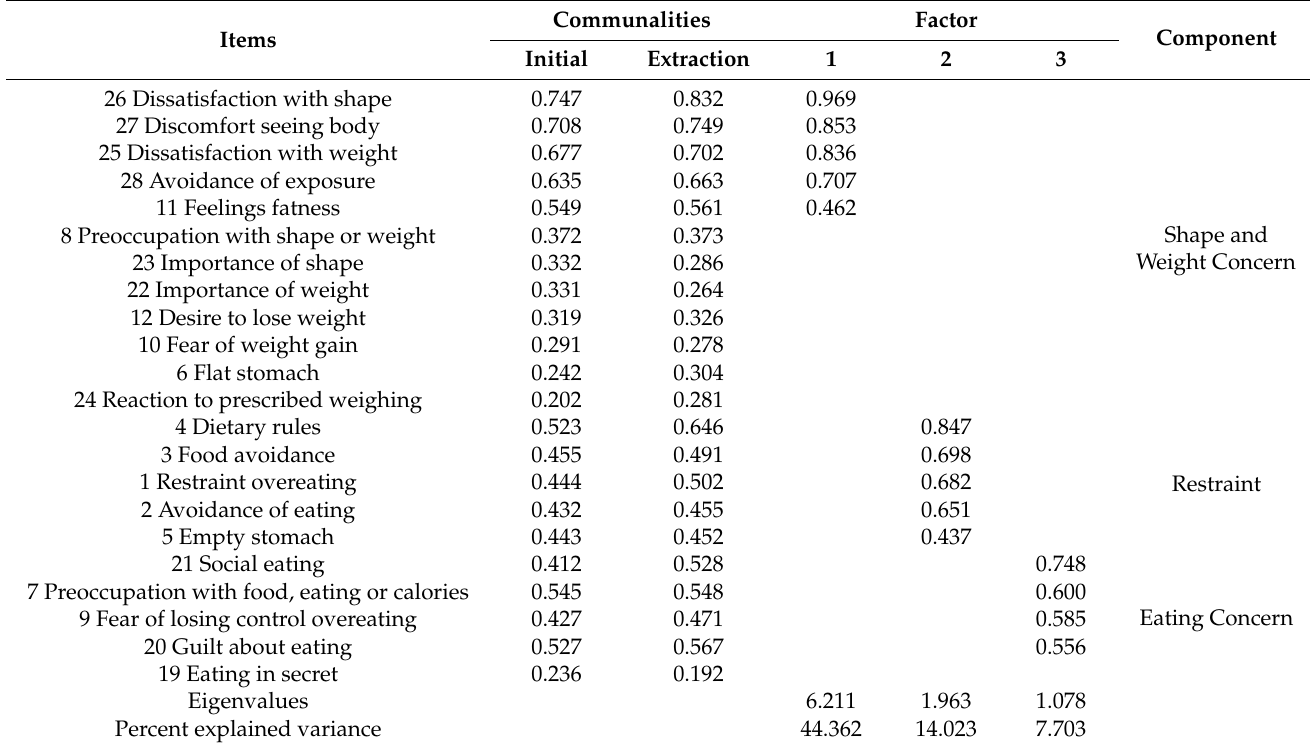
Table 3. Exploratory factor analysis (EFA) for 14 items from the Eating Disorder Examination